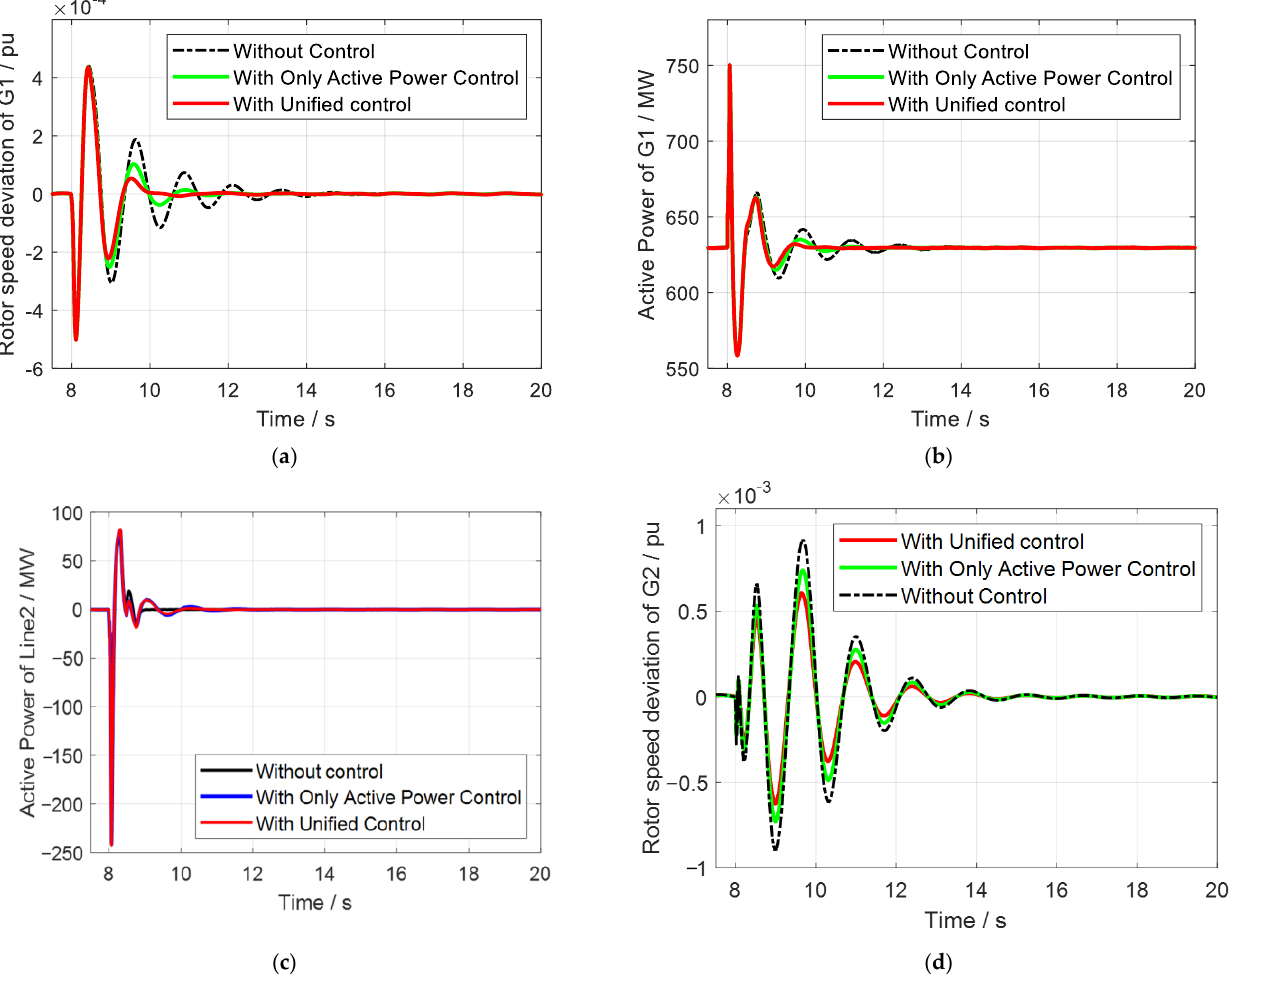
Figure 12. Simulation situations in case1. ( a ) The rotor speeds deviation of plant 1 with and without control in different situations. ( b ) The output active power of plant 1 with and without control in different situations. ( c ) The active power transmitted on Line 2 with and without control in different situations. ( d ) The rotor speeds deviation of plant 2 with and without control in different situations.